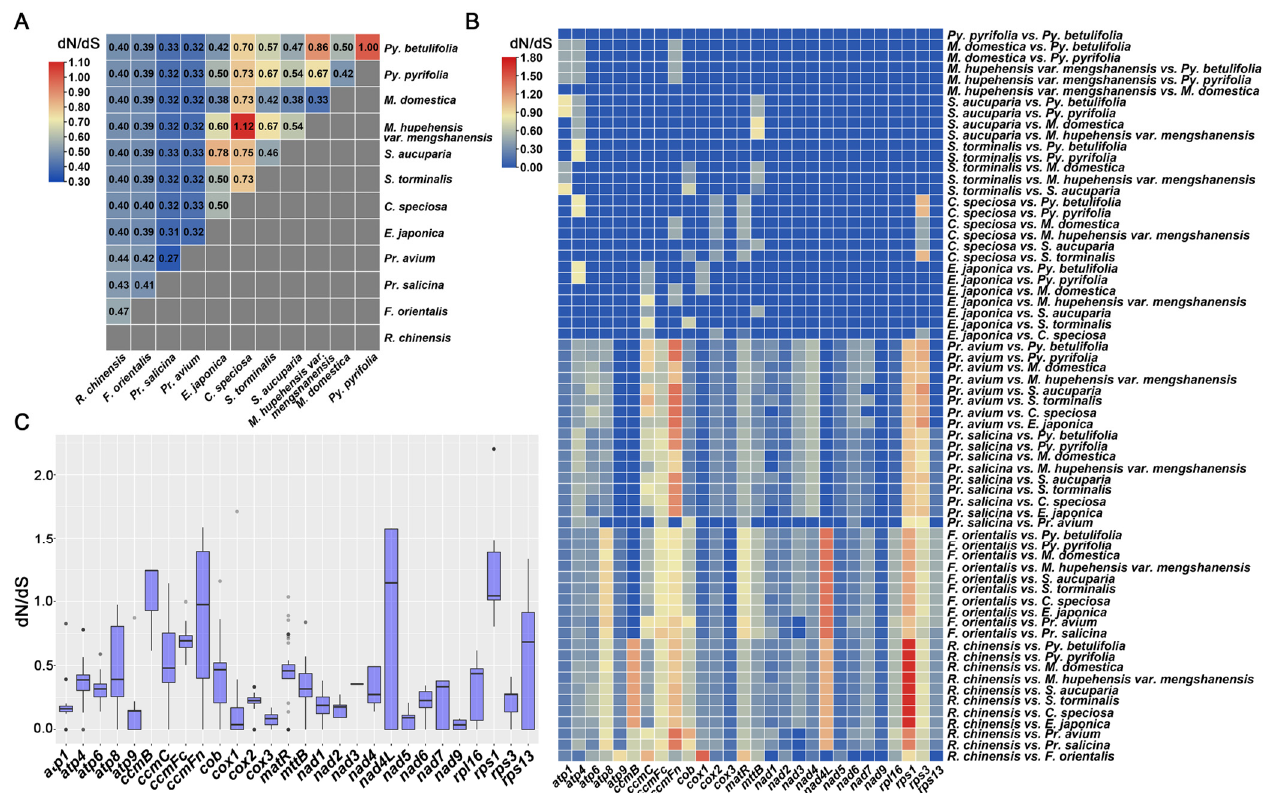
Figure 8. Pairwise dN/dS values in 12 species of Rosaceae: ( a ) A heatmap of the pairwise dN/dS values between each pair of sequences in the polygenic nucleotide alignment. The scale factor associated with each value is displayed at the top left of the drawing; ( b ) the pairwise dN/dS values of all PCGs in 12 species from the Rosaceae; ( c ) the boxplot of pairwise dN/dS values of all PCGs.